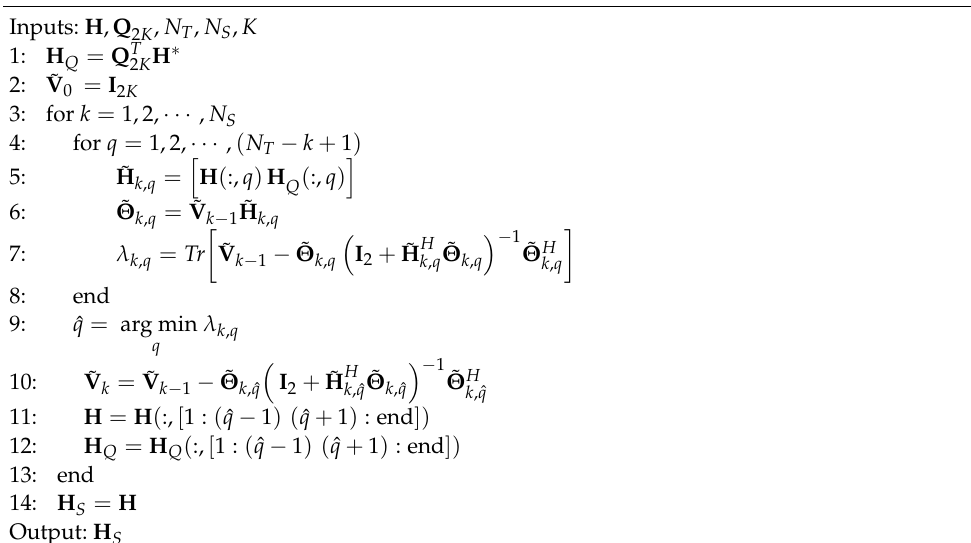
Algorithm 2 SNR-based efficient incremental TAS selection